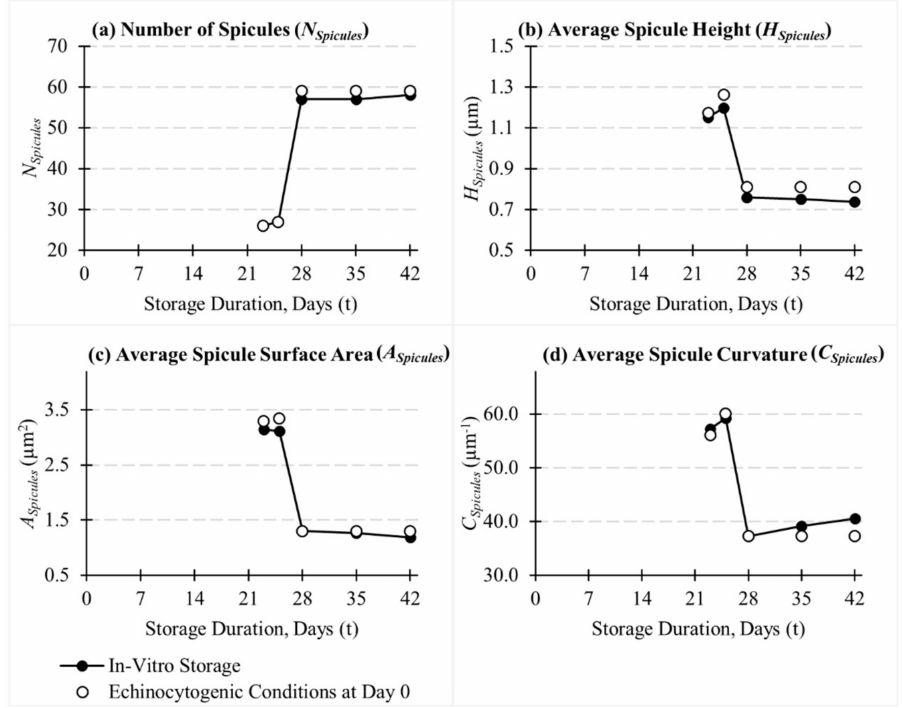
Figure 6. Comparison of ( a ) number of spicules ( N Spicules ), ( b ) average spicule height ( H Spicules ), ( c ) average spicule surface area ( A Spicules ) and ( d ) average spicule curvature ( C Spicules ) of CG-RBC membrane model-predicted echinocyte II (at 22 ≤ t < 24), echinocyte III (at 24 ≤ t < 26) and sphero-echinocyte (at 26 ≤ t ≤ 42) during in-vitro storage and under echinocytogenic shape-transforming